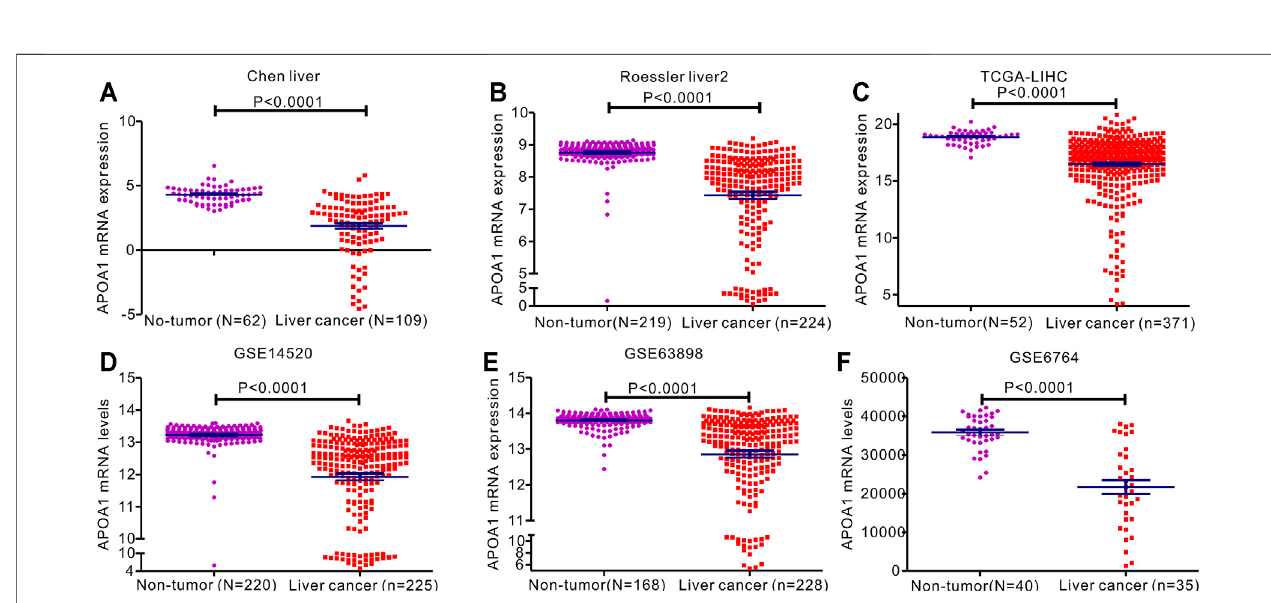
FIGURE 2 | Expression of APOA-1mRNA expression in patients with HCC. Levels of serum APOA-1 are higher in healthy controls than in patients with HCC. Differential expression of APOA-1 in (A) Chen liver; (B) Roessler liver 2; (C) TCGA-LIHC; (D) GSE14520; (E) GSE63898; and (F) GSE6764.